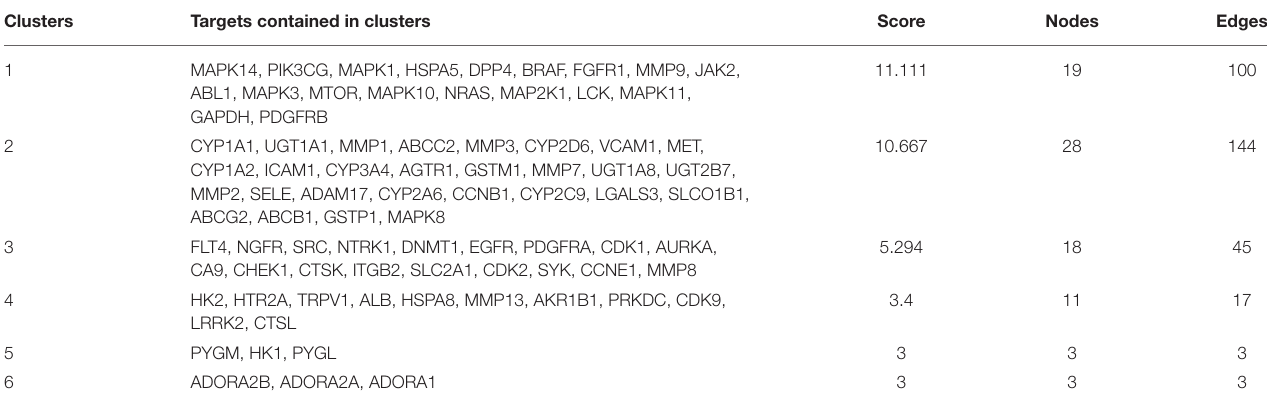
TABLE 2 | Cluster details based on MCODE plug-in. Clusters Targets contained in clusters Score